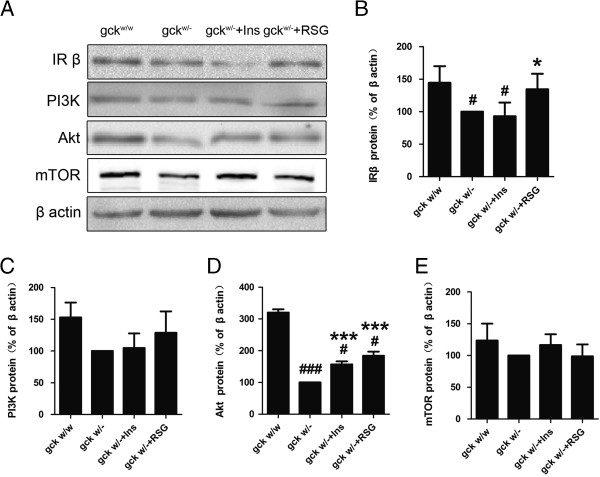
Changes in the protein levels of Insulin signaling pathway in hearts of 60-week old liver-specific gck knockout mice. Representative Western blots images (A) with quantification of IR (B), PI3K (C), Akt (D), and mTOR (E) from heart homogenates of wild-type (gckw/w) and gck knockout (gckw/–) mice as well as knockout mice treated with insulin or rosiglitazone for 4 weeks are shown. n = 3 for all samples. Asterisk (*) refers to statistical significance (P < 0.05 for * and P < 0.001 for ***) in comparisons with gckw/– mice, while # refers to statistical significance (P < 0.05 for # and P < 0.001 for ###) in comparisons with gckw/w mice.